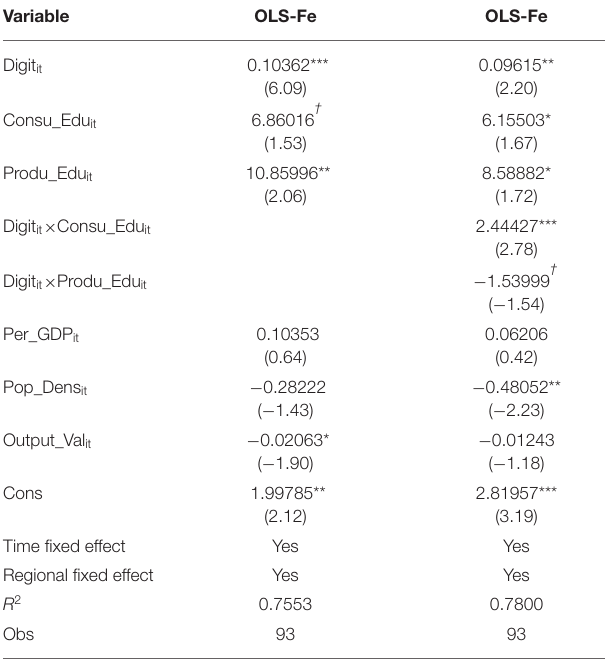
TABLE 6 | Robustness test